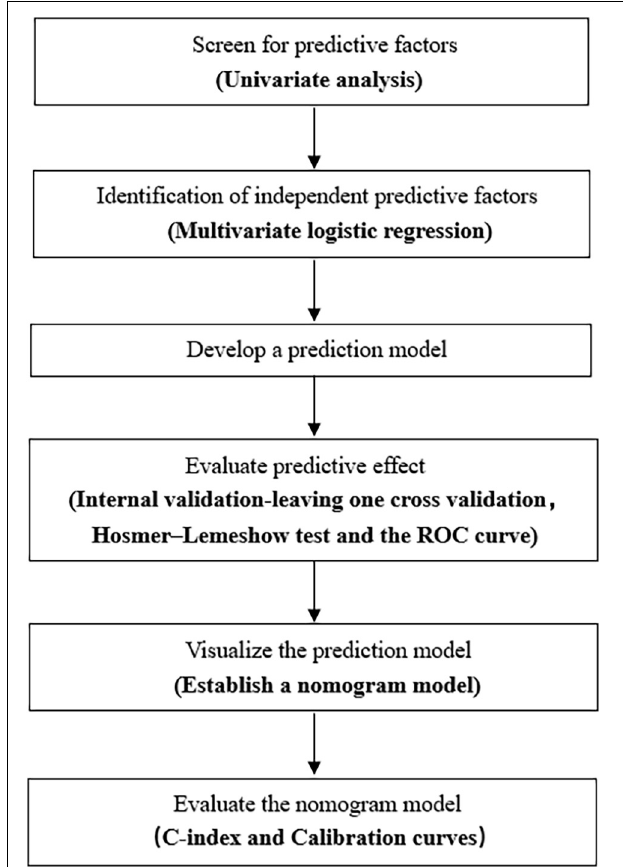
FIGURE 1 | A flowchart displaying the process of building the nomogram.